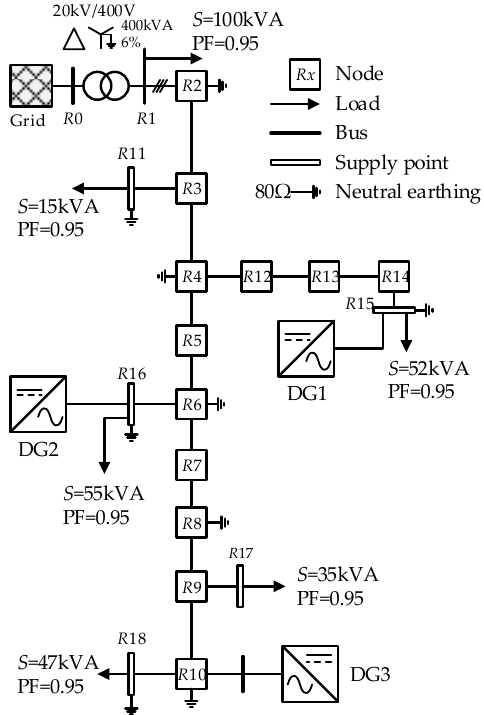
Figure 7. Modified benchmark of the European LV distribution network. Table 1. Line parameters of the benchmark.